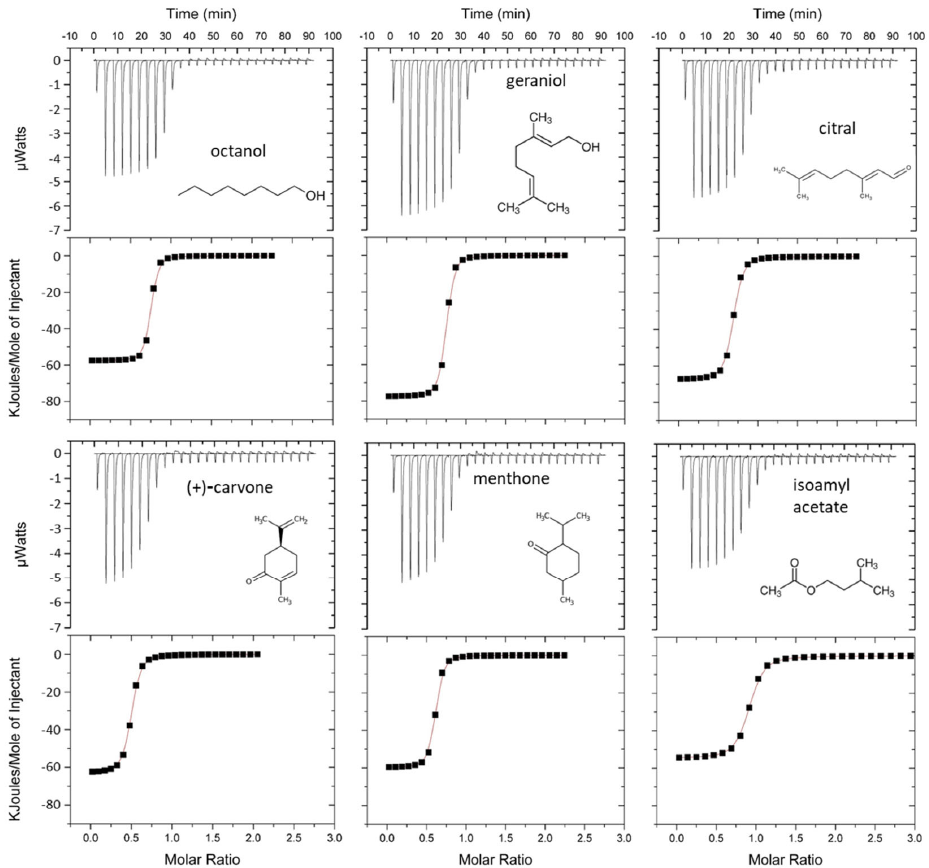
Figure 4. Binding properties of mOBP5 measured using isothermal titration calorimetry. The experiments have been carried out at 25 °C, in 100 mM phosphate buffer, pH 7.5. The concentrations of the reactants were 250 μ M odorant and 25 μ M mOBP5. The top panels are the thermograms, and the bottom panels are the fitted binding isotherms. The structures of the odorants are shown.